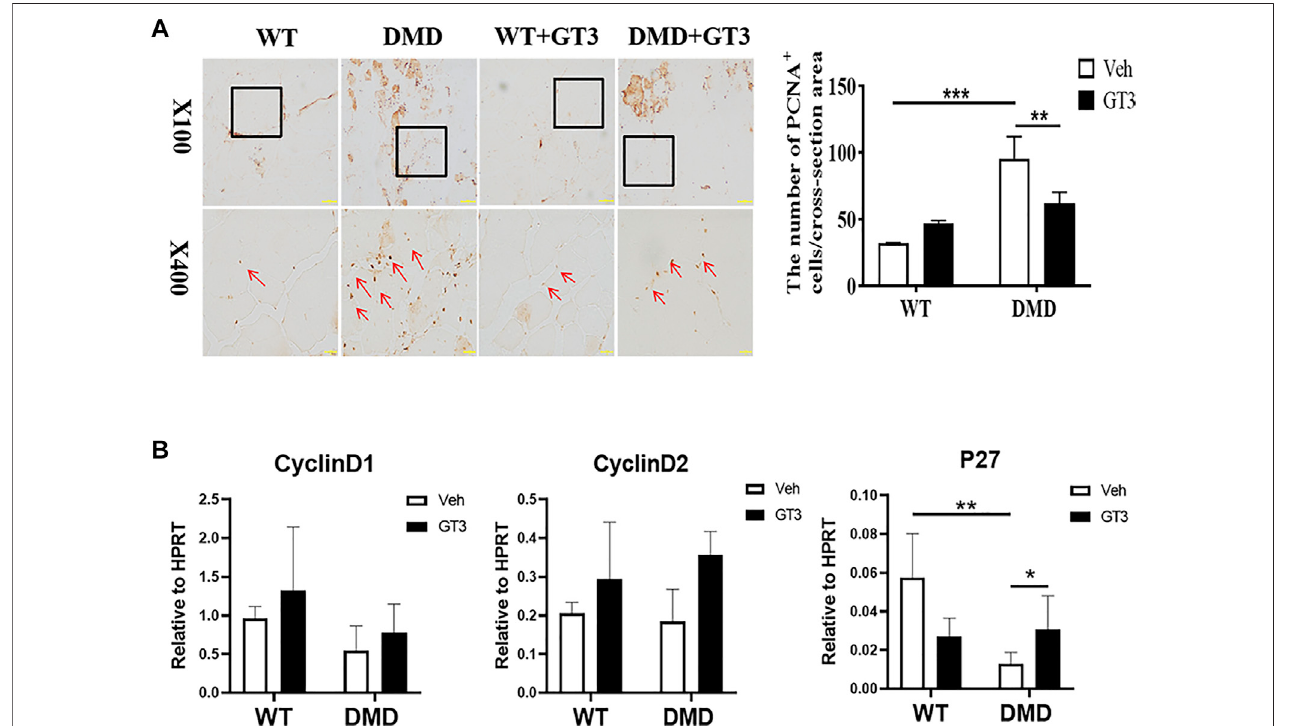
FIGURE6| EffectsofGT3onproliferationofmusclecells. (A) Thetibialisanteriorwasextracted48 hafterGT3treatmentin40-week-oldWTandDMDmice.PCNA positive cells were stained with brown (red arrow, left panel). Numbers of PCNA positive cells were counted in each fi eld. Data were presented at means ± SEM ( n = 6) with two-way ANOVA analysis. ** p < 0.01, *** p < 0.001. (B) Gene expression of tibialis anterior muscle cells was detected by RT-PCR after GT3 treatment. Data were presented at means ± SEM ( n = 6) with two-way ANOVA analysis. * p < 0.05, ** p < 0.01.